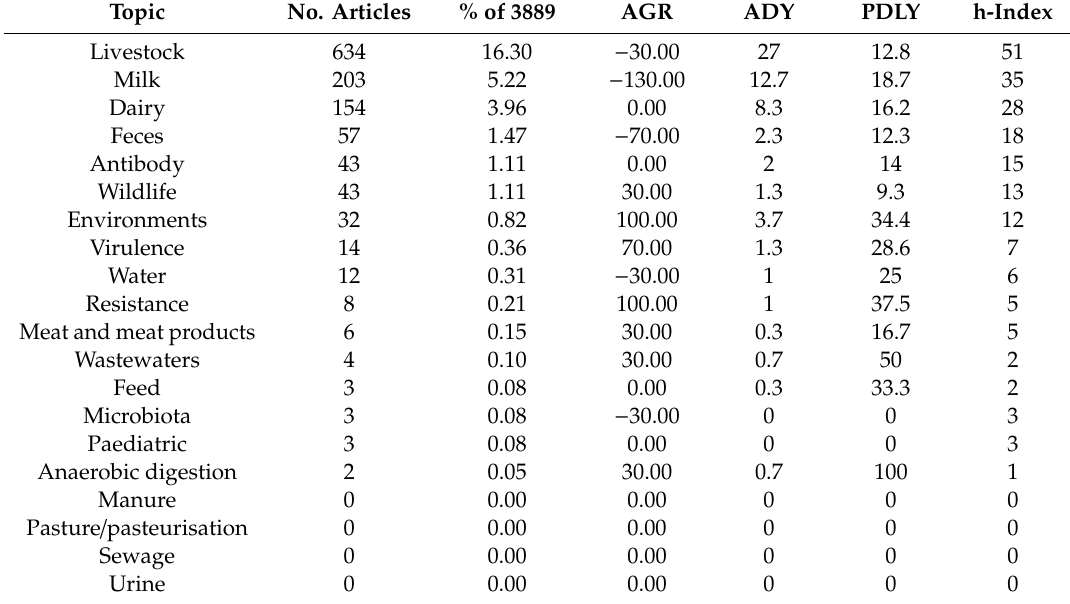
Table 6. Trend and growth of MAP research-based research topics from